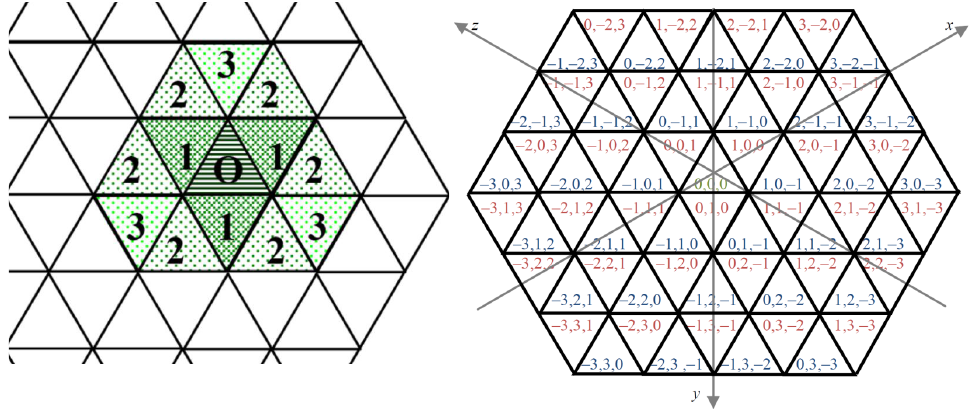
Figure 1. Various (strict) neighborhood relations ( left ) and a part of the grid with the symmetric coordinate system ( right